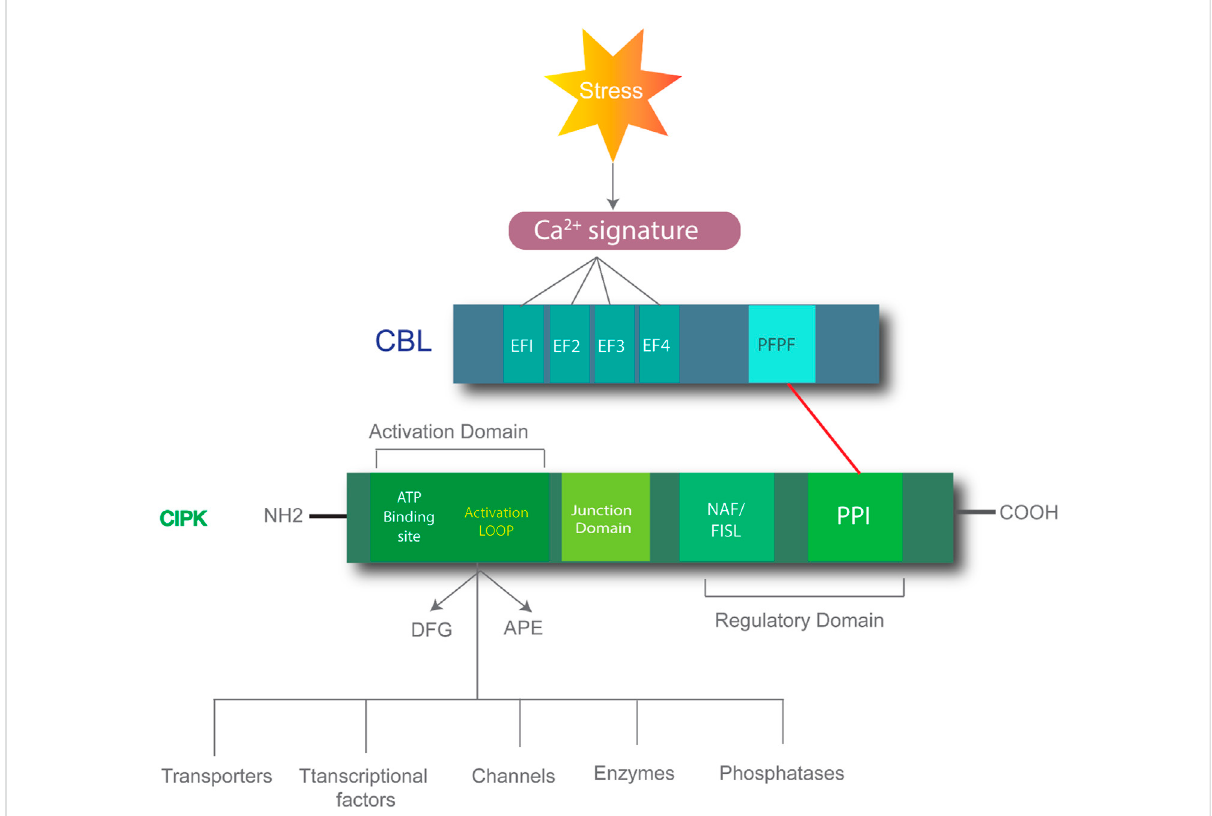
FIGURE 1 Process of CBL-CIPK complex-mediated responses. Stress can induce the calcium ion signatures which bind to EF1-EF4 domains on the CBL. CIPK consists of the N-terminal domain comprising the activation domain and the C-terminal domain comprising the regulatory domain, which includes the NAF/FISL and PPI domains. The red line shows the CBL and CIPK interaction. This complex formation regulates downstream